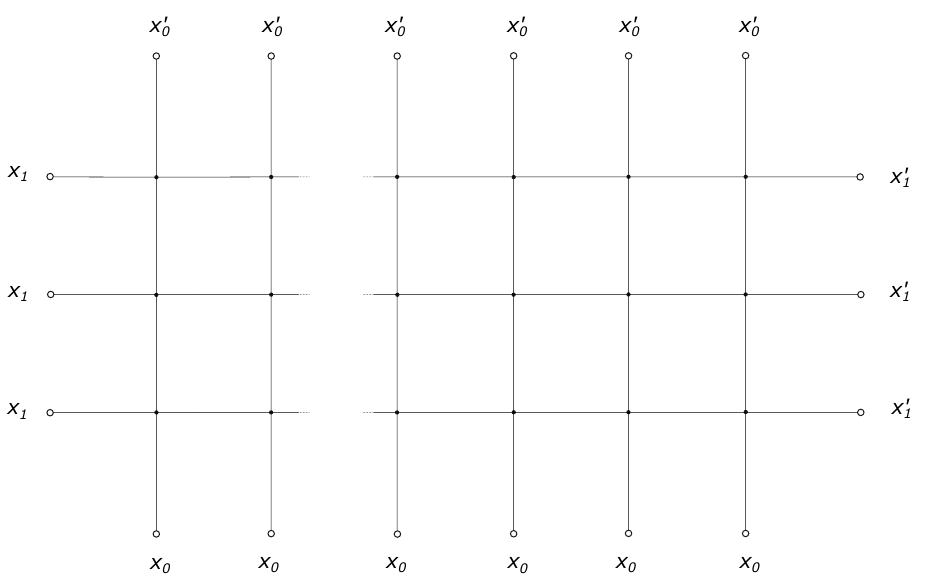
Figure 1 . Graphic representation of the fishnet Feynman integral (1.1) for a size of the square lattice bulk N × L with N = 3 horizontal and L vertical lines. Solid lines are the standard scalar propagators 1 / ( x − y ) 2 where x and y are the two endpoints of each segment. Intersection points between two lines (black dots) are integrated over. The topology of the bulk is the one of a square- lattice “fishnet”, and the boundary points are identified into four points ( x